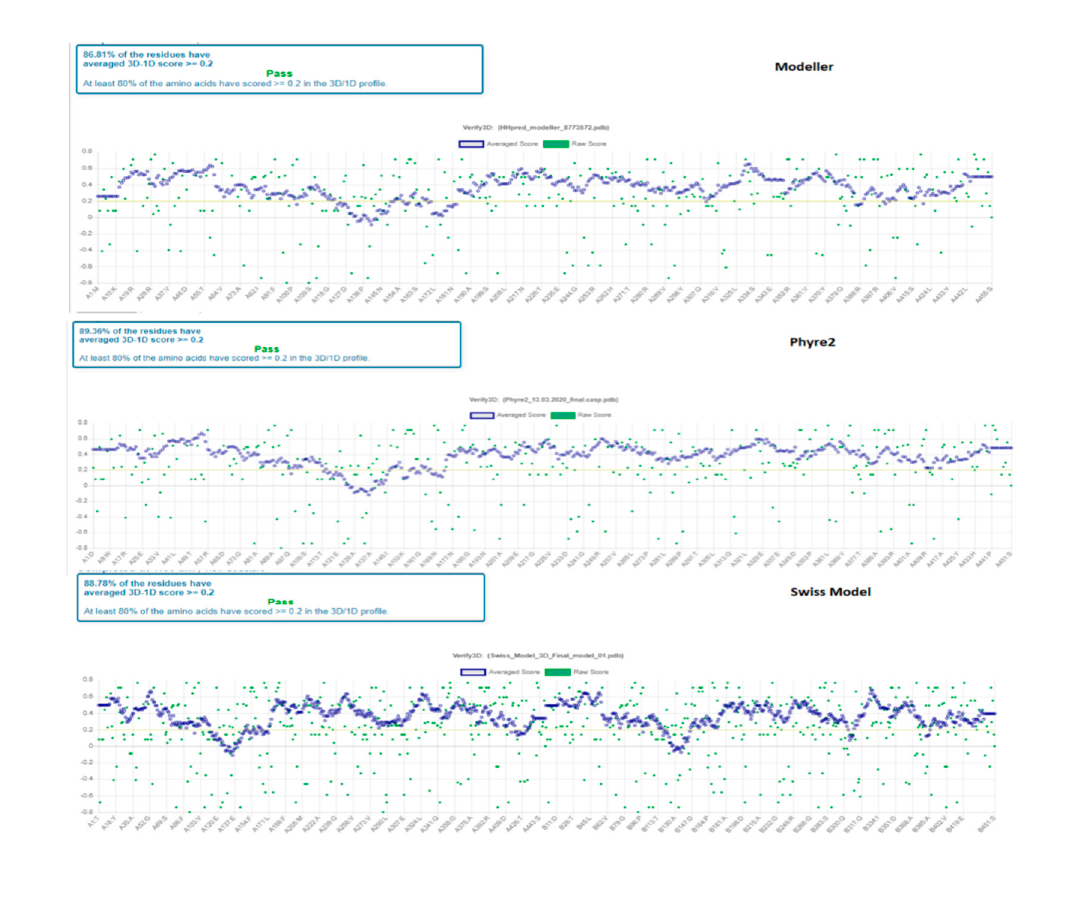
Figure 4. Verify 3D